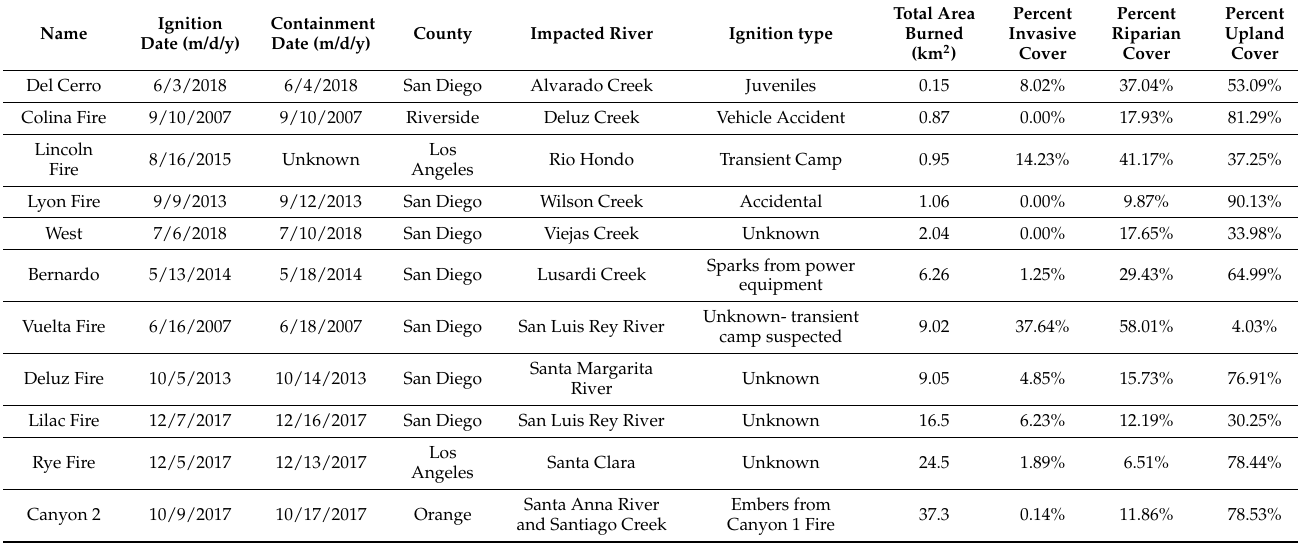
Table 1. Characteristics for the eleven selected fires in order of ascending total acres burned. Note that only the percentages of invasive, riparian, and upland cover, which are relevant to this study, are